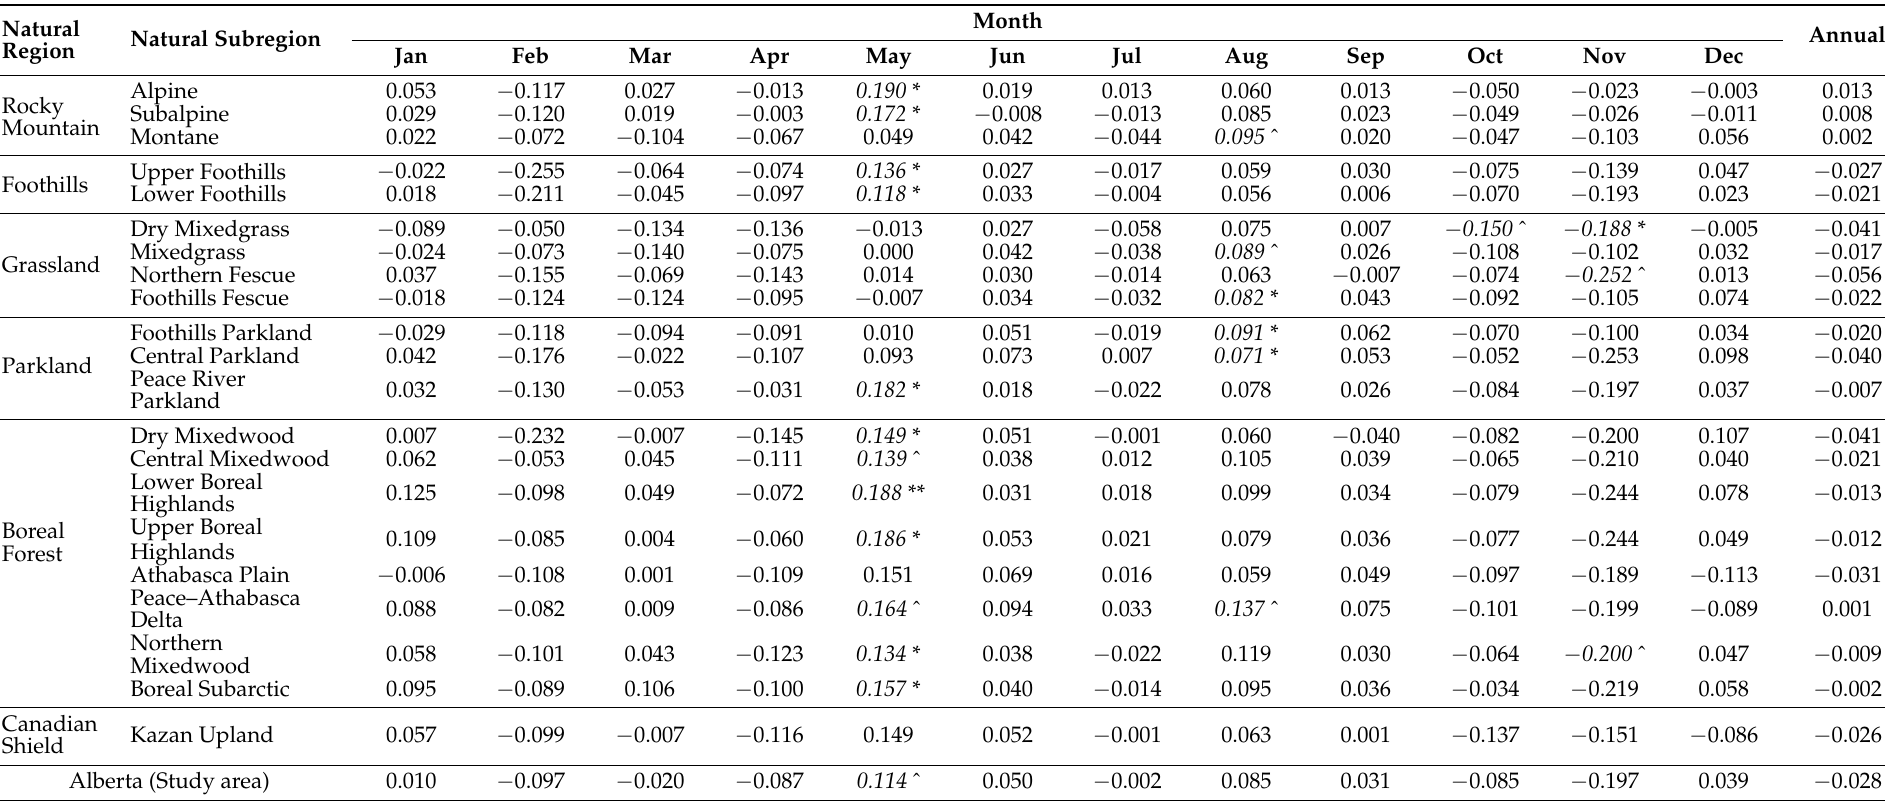
Table 2. Nighttime LST trend ( ◦ C/yr) during 2001–2020 (monthly and annual) for the 21 natural subregions in Alberta using Mann–Kendall test. The significant values are highlighted italic, where ˆ, *, and ** indicate the 90, 95, and 99% confidence levels, respectively. Natural